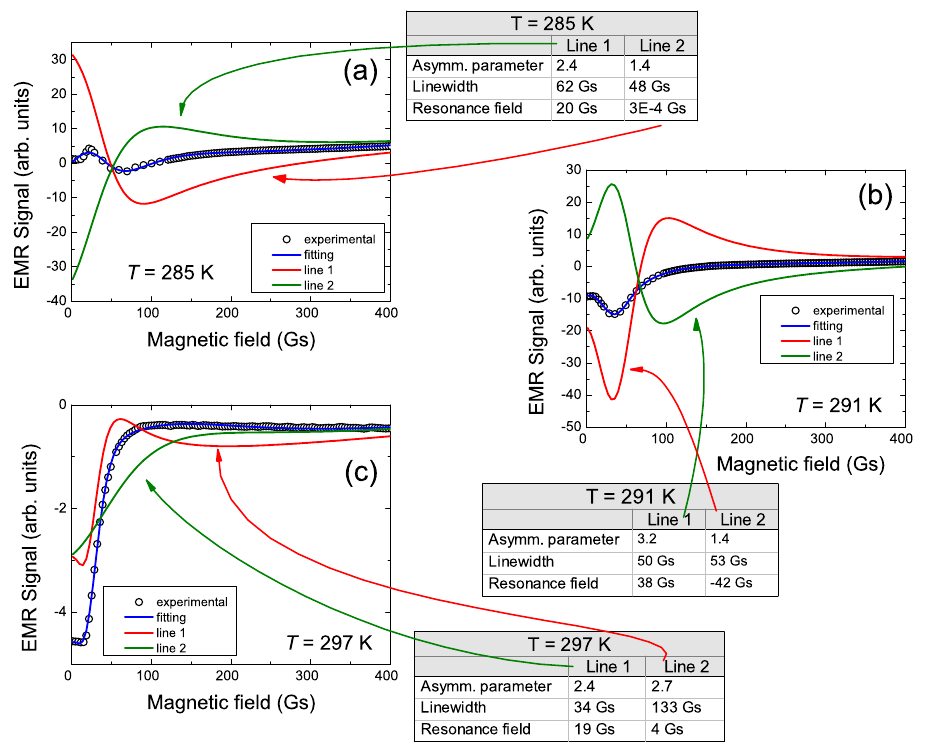
Figure 3. Representative LFMA signals for Ni 50 Mn 35.5 In 14.5 annealed ribbon, their fitting by Dyson curves and fitting parameters at 286 K ( a ), 291 K ( b ) and 297 K ( c ).